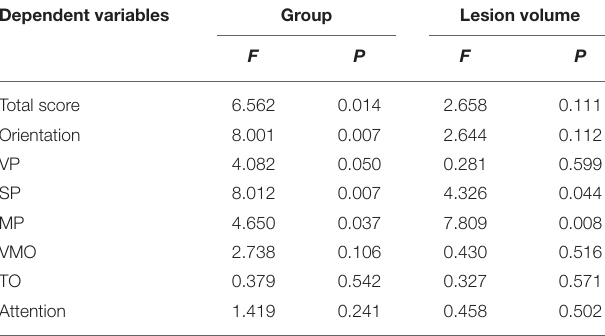
TABLE 5 | The effect of lesion volume on the difference of LOTCA scores between FAG group and non-FAG